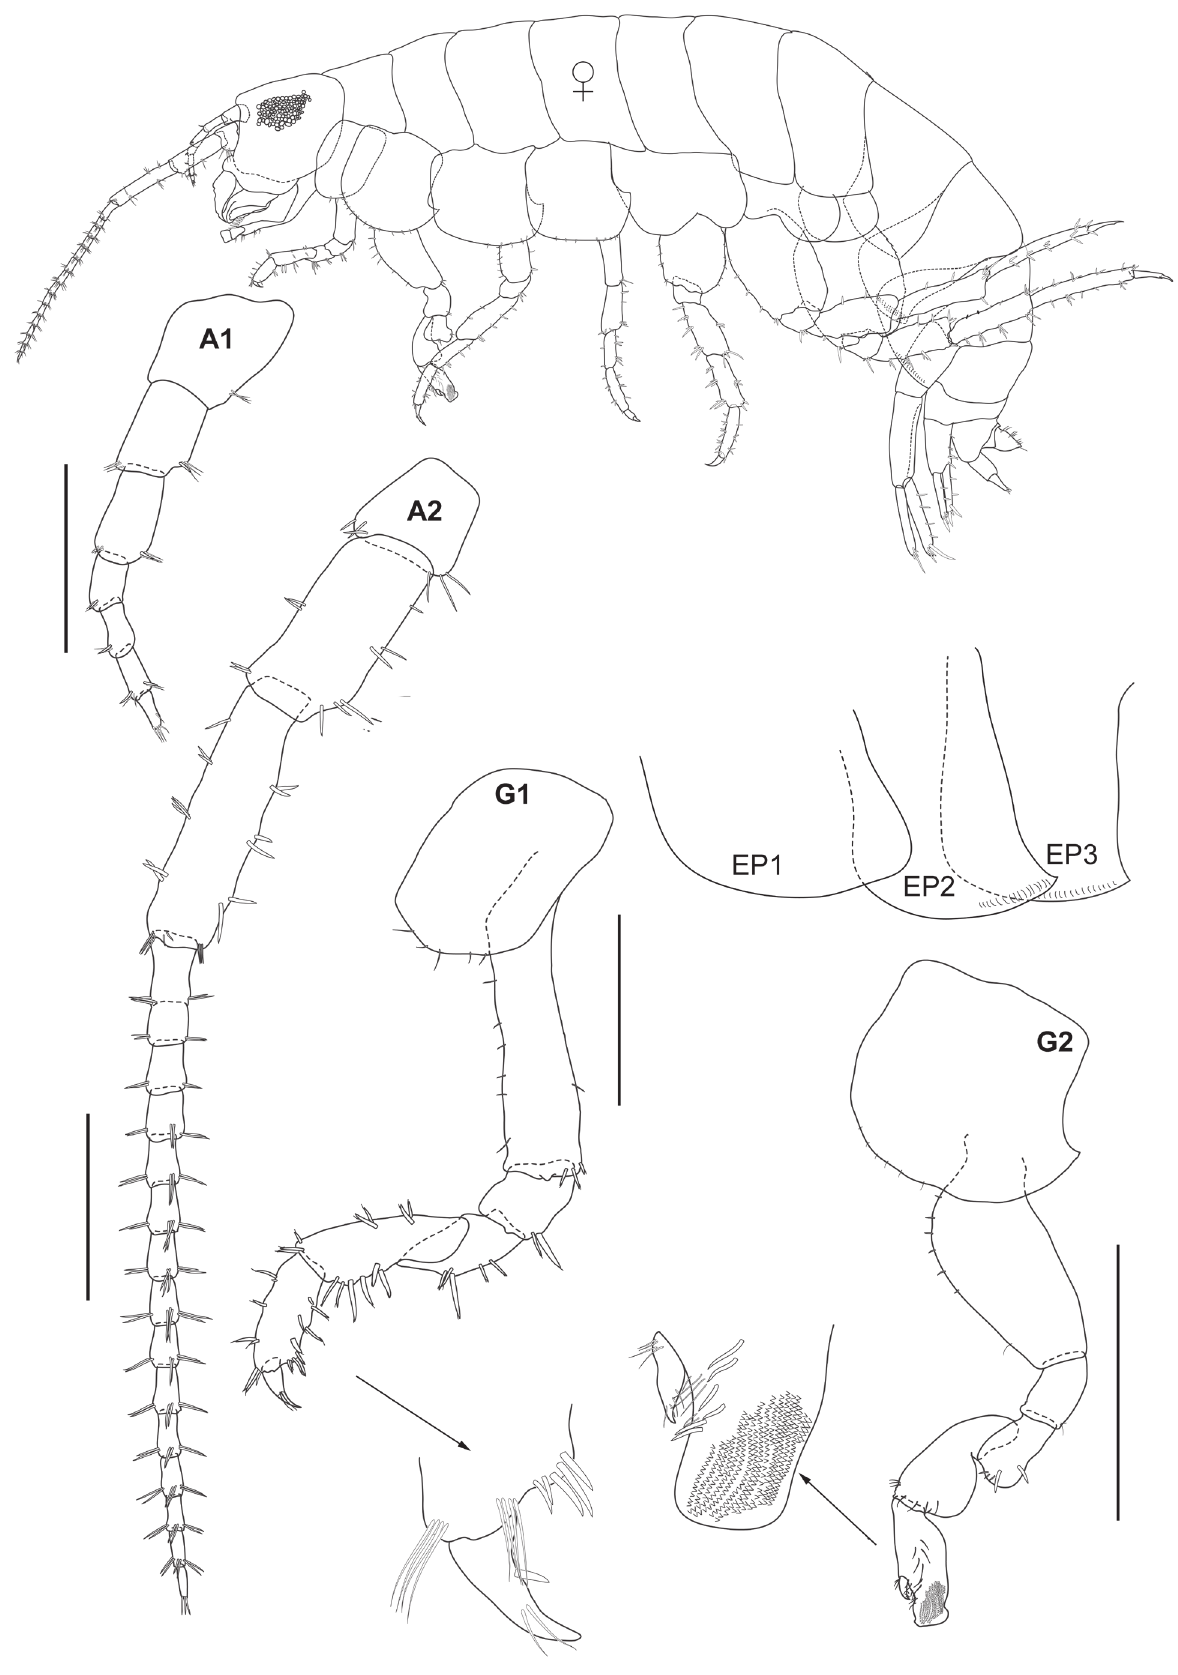
Figure 3. Floresorchestia samroiyodensis sp. n., holotype, female, (PSUZC-CR-0275) 10.6 mm. Khao Sam Roi Yod National Park. Scales for A1 and A2 represent 0.5 mm, G1 and G2 represent 0.2